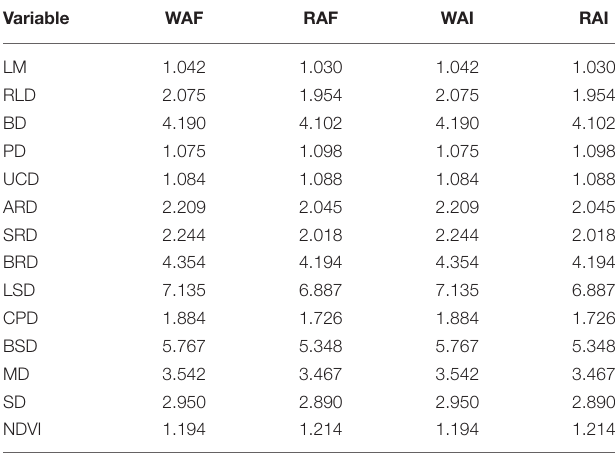
TABLE 6 | The variance inflation factor of MLR-LT.